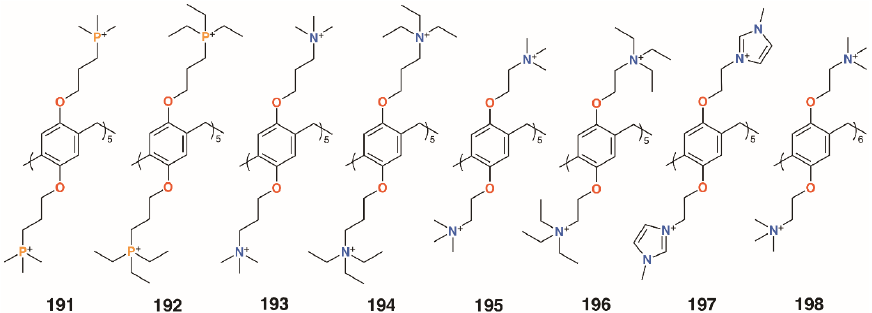
Figure 33. Cohen’s charged pillar[ n ]arenes.